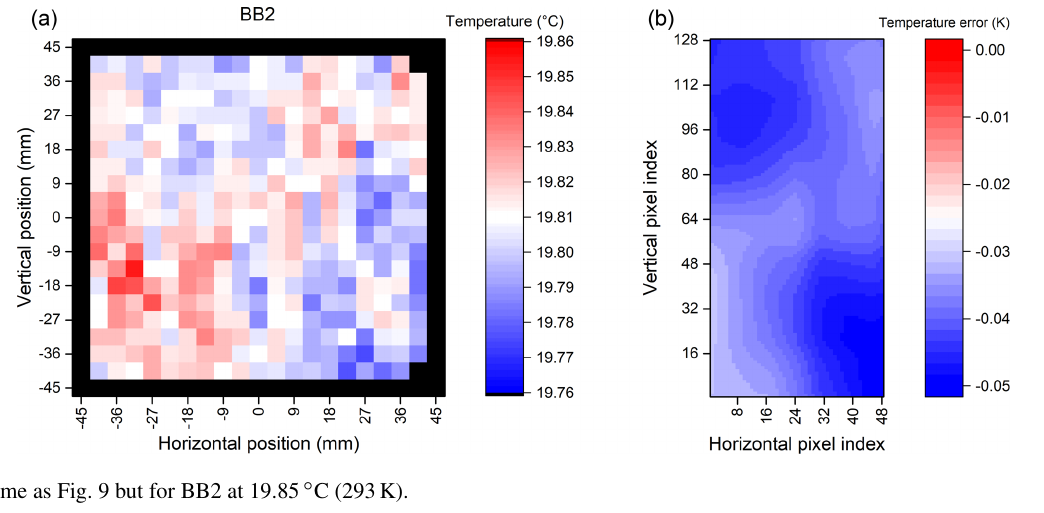
Figure 9. Same as Fig. 9 but for BB2 at 19.85 ◦ C (293K).